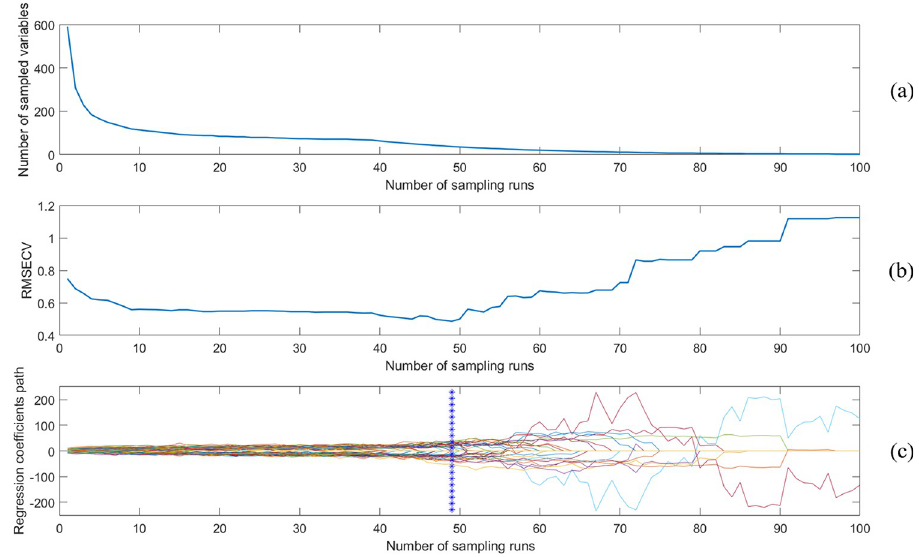
Fig 11. Graph of CARS characteristic wavelengths selection